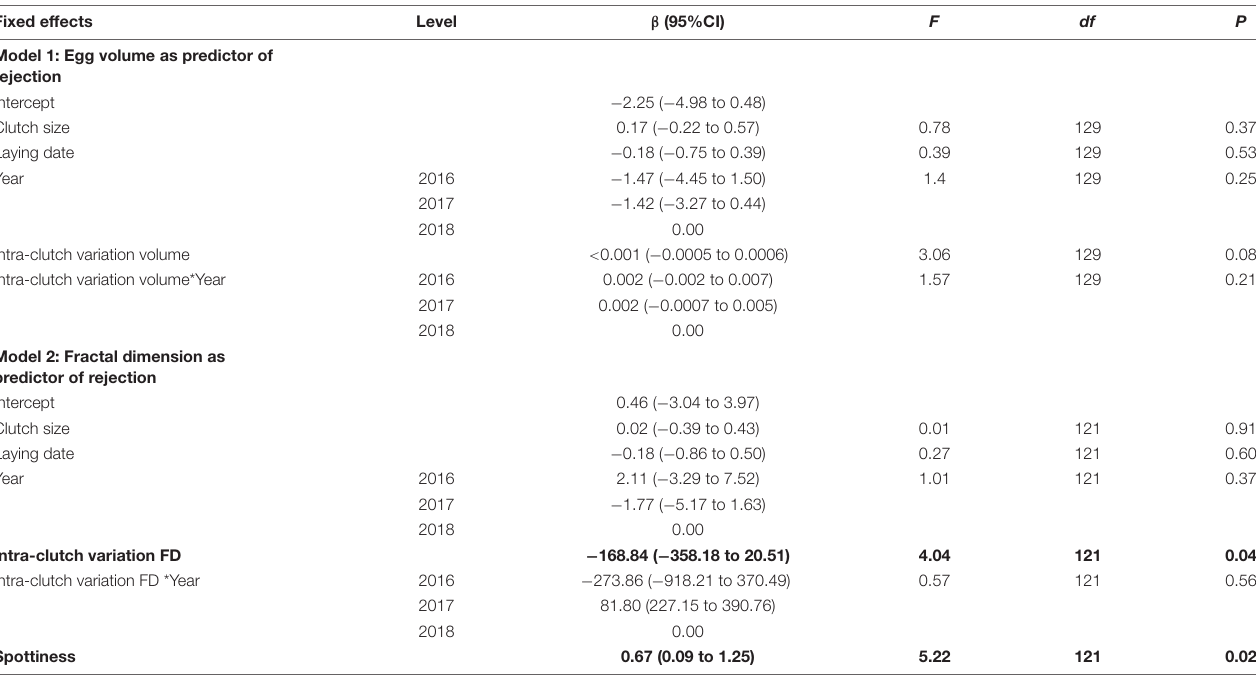
TABLE 1 | Intra-clutch variation in egg appearance in relation to rejection of model